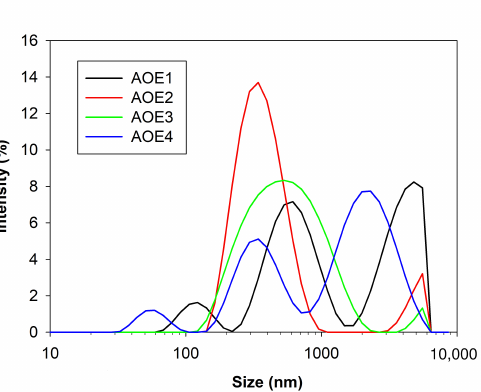
Figure 1. Droplet size distribution of O/W emulsions stabilized by mixed particulate emulsifiers (AOE1, AOE2, AOE3, AOE4).